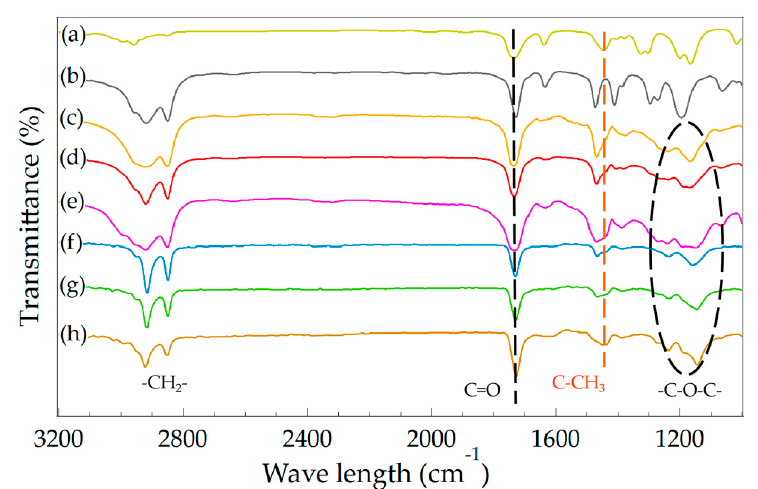
Figure 8. FTIR spectra of microcapsule and sheet samples for BeA- co -MMA copolymer and monomers MMA and BeA. (a) MMA, (b) BeA, (c) MC(BeA- co -MMA)5, (d) MC(BeA- co -MMA)3, (e) MC(BeA- co -MMA)1, (f) ST(BeA- co -MMA)5, (g) ST(BeA- co -MMA)3, and (h) ST(BeA- co -MMA)1.